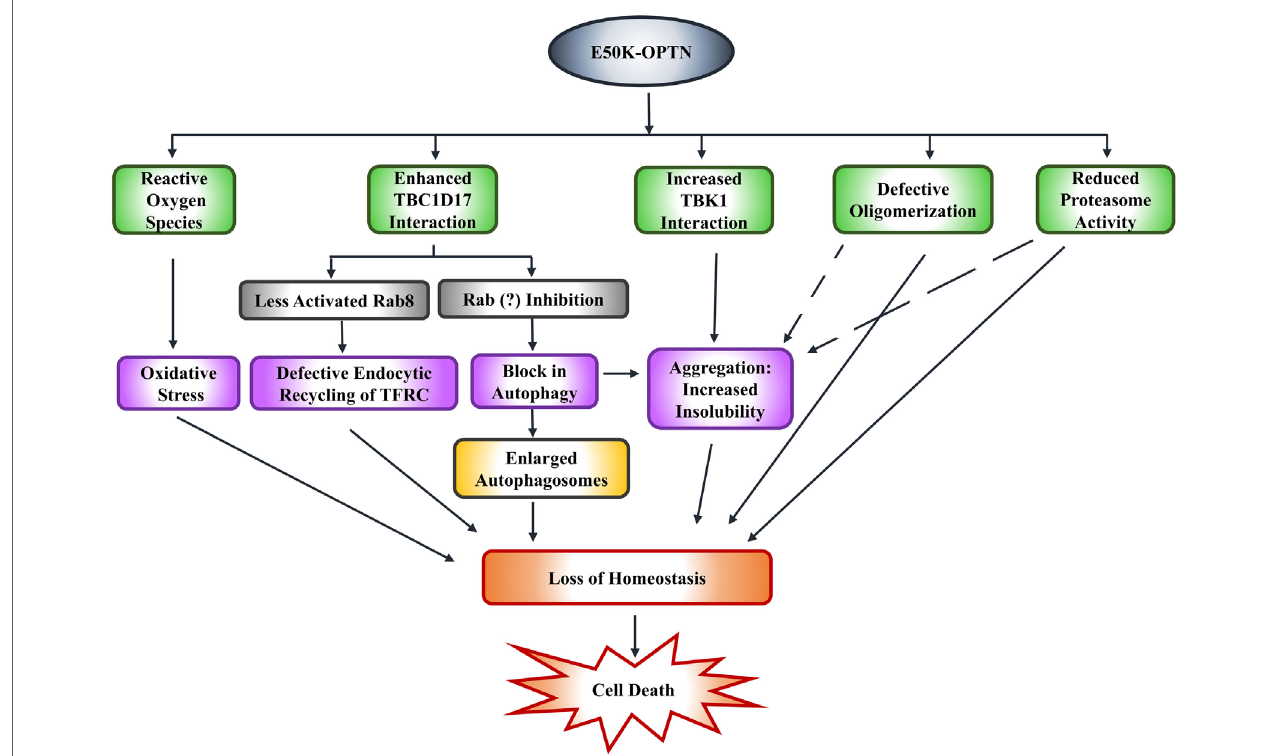
FiGURe 3 | E50K-optineurin induces death of retinal cells by various mechanisms that may contribute to glaucoma